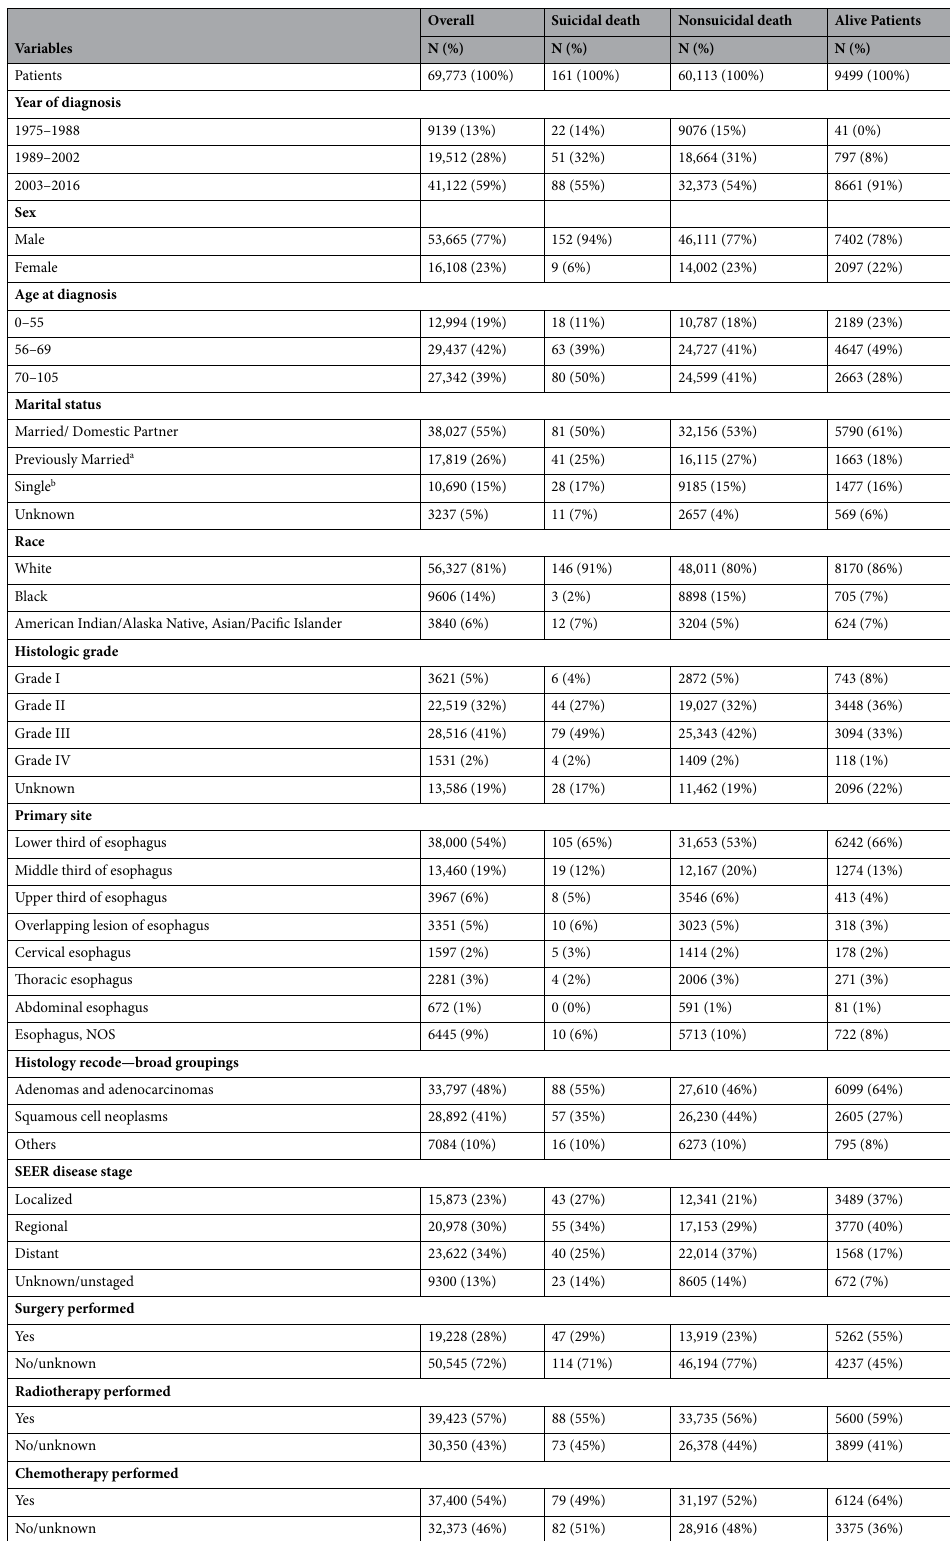
Table 1. Baseline characteristics of patients with esophageal cancer stratified by suicidal death, nonsuicidal death and alive patients. SEER, the surveillance, epidemiology, and end results program. a Included divorced, widowed and separated. b Included never